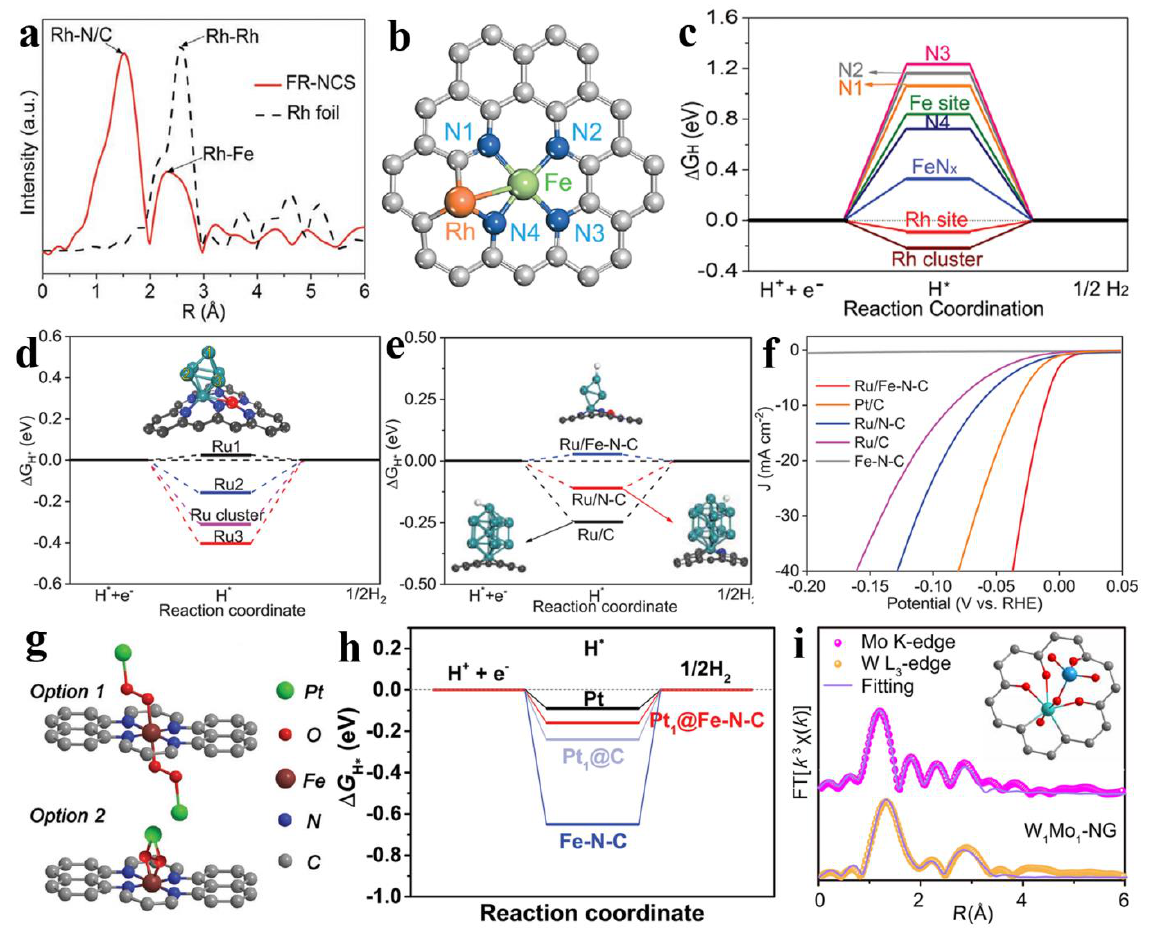
Figure 4. ( a ) FT−EXAFS data of Rh in the FR−NCS. ( b ) Possible sites to adsorb H. ( c ) ΔG H* of